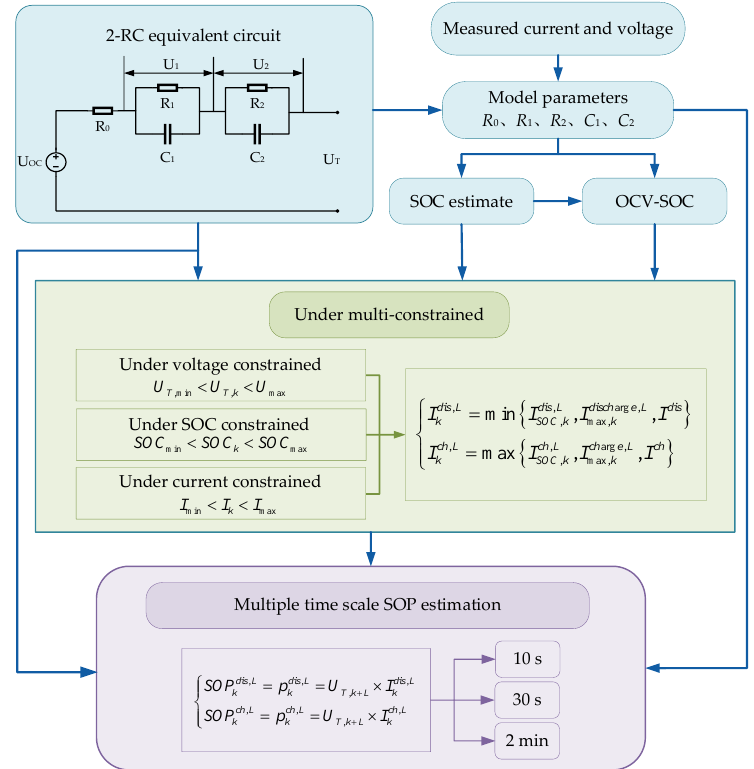
Figure 5. SOP estimation process.